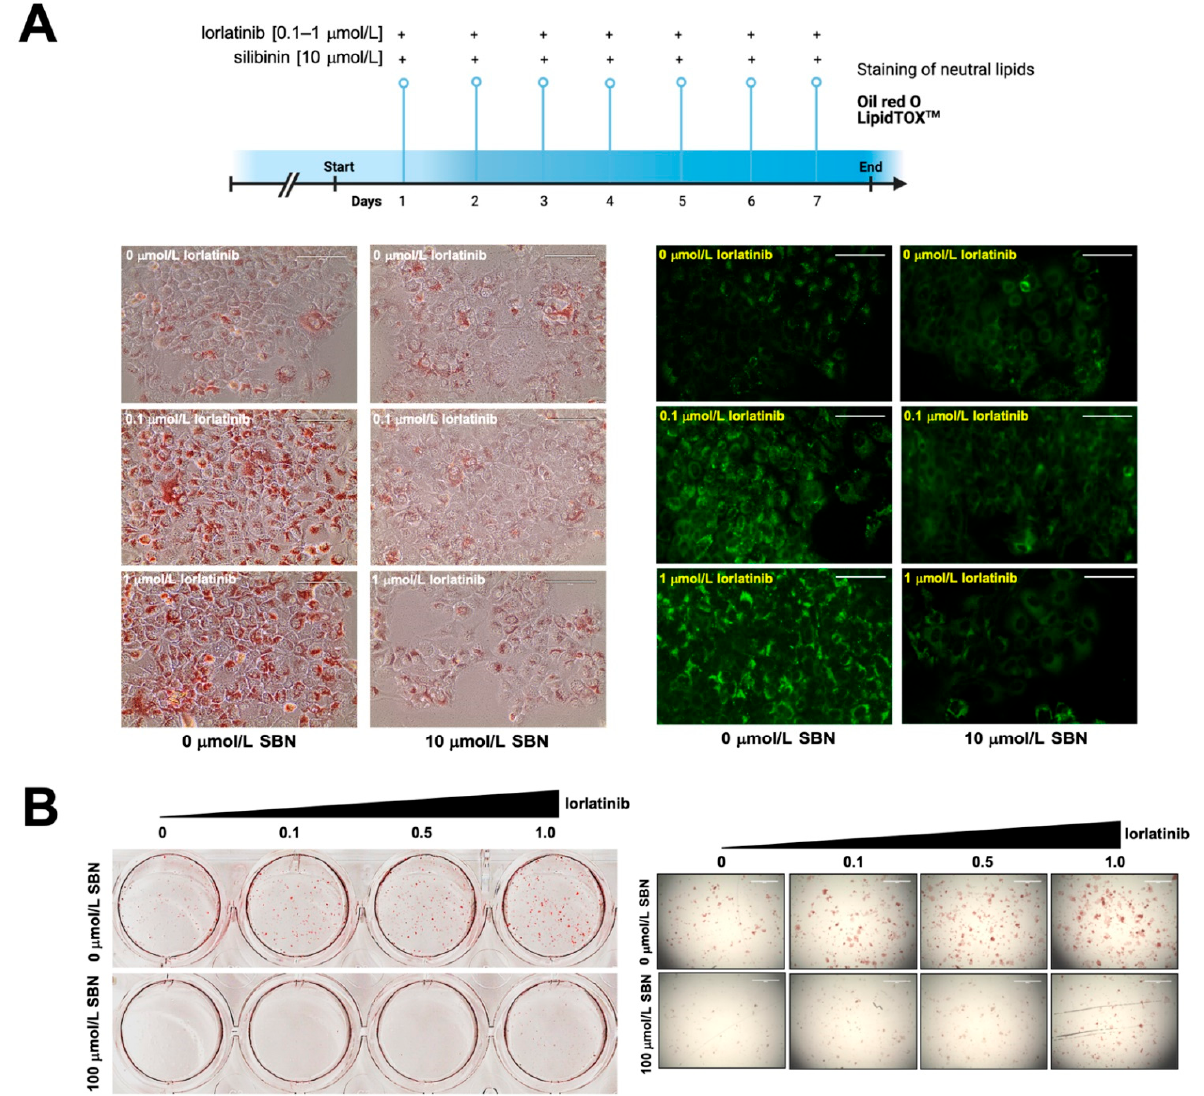
Figure 2. Silibinin inhibits the chronic accumulation of neutral lipids in lorlatinib-treated hepatic cells ( A ) Conventional indices of fatty acid liver disease —-lipid droplet content in hepatic cells—- were assessed using Oil Red O- and LipidTOX green-based staining of neutral lipids in Huh-7 ( A ) and HepG2 ( B ) cells chronically ( A ) or acutely ( B ) exposed to lorlatinib in the absence or presence of silibinin. (Chronic exposure: 7 days at 10 μ mol/L silibinin; acute exposure: 48 h at 100 μ mol/L silibinin). Scale bar = 100 μ m.